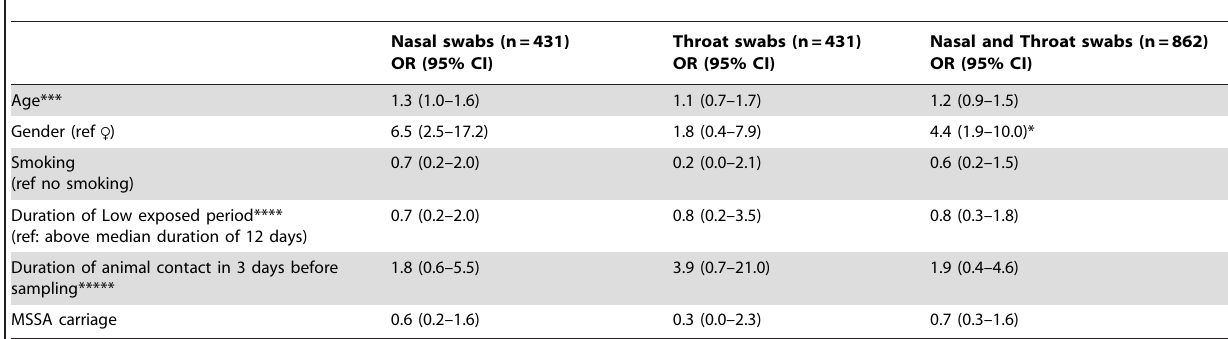
Table 6. Associations between MRSA carriage and determinants, including MSSA nasal carriage in a multivariate analysis.